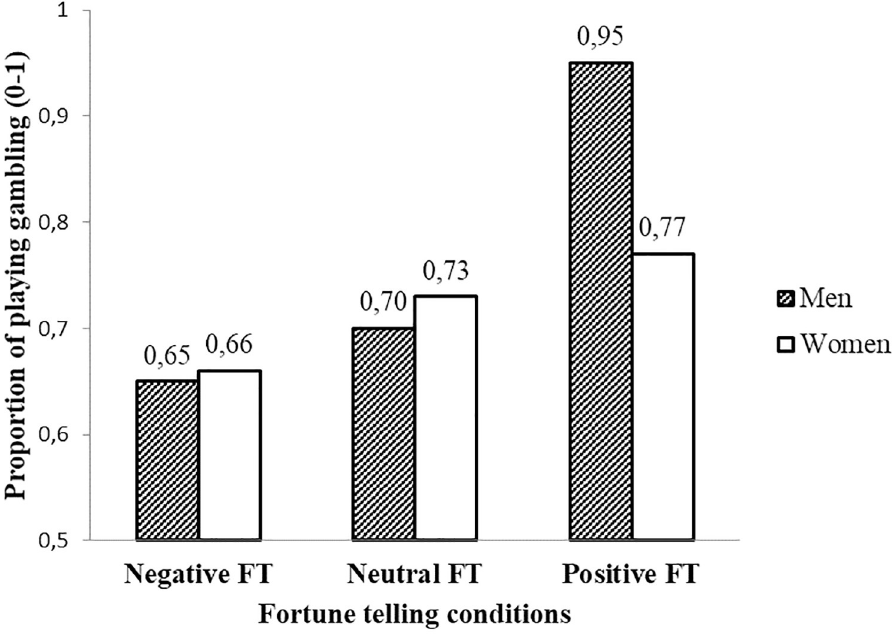
Fig 3. Proportion of playing a gambling game among fortune telling conditions for men and women in Study 3.